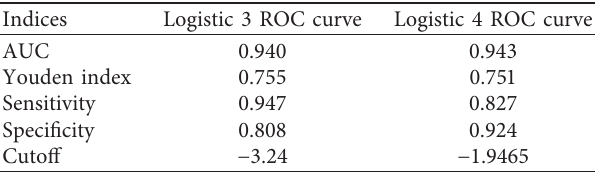
Figure 5: ROC curve of risk factors for predicting COVID-19 patients developing severe illnesses. Table 10: Index analysis of Logit (3) and Logit